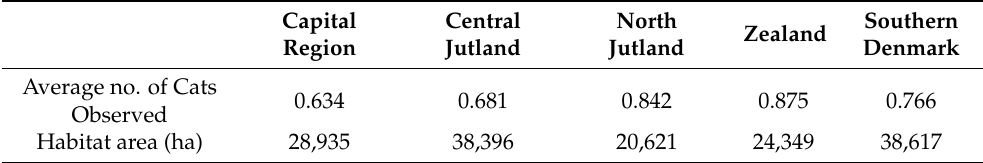
Table A3. Average number of cats observed by respondents together with the areas (ha) of the suburban habitat within each of the five regions in Denmark are shown